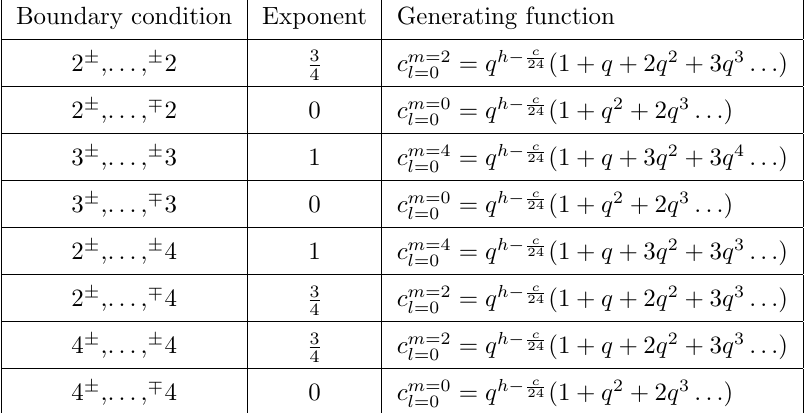
Table 3 . String functions in the k = 6 antiferromagnetic RSOS model with the alternating bound- ary condition on both sides. Note that the boundary condition written in the table corresponds to the boundary condition when L is even. When the left and right boundary conditions are \cor- related" for L even then we take \anticorrelated" boundary conditions for L odd, and vice versa. The string functions are expanded up to the terms we can clearly observe on the